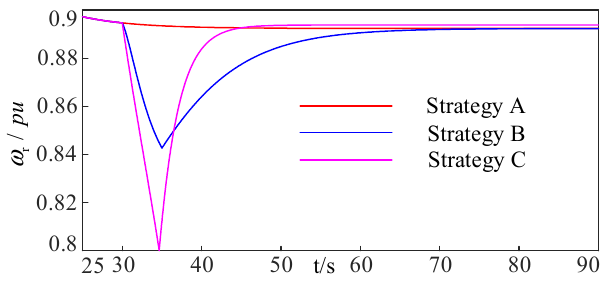
Figure 13. Rotor speed responses under different control strategies.